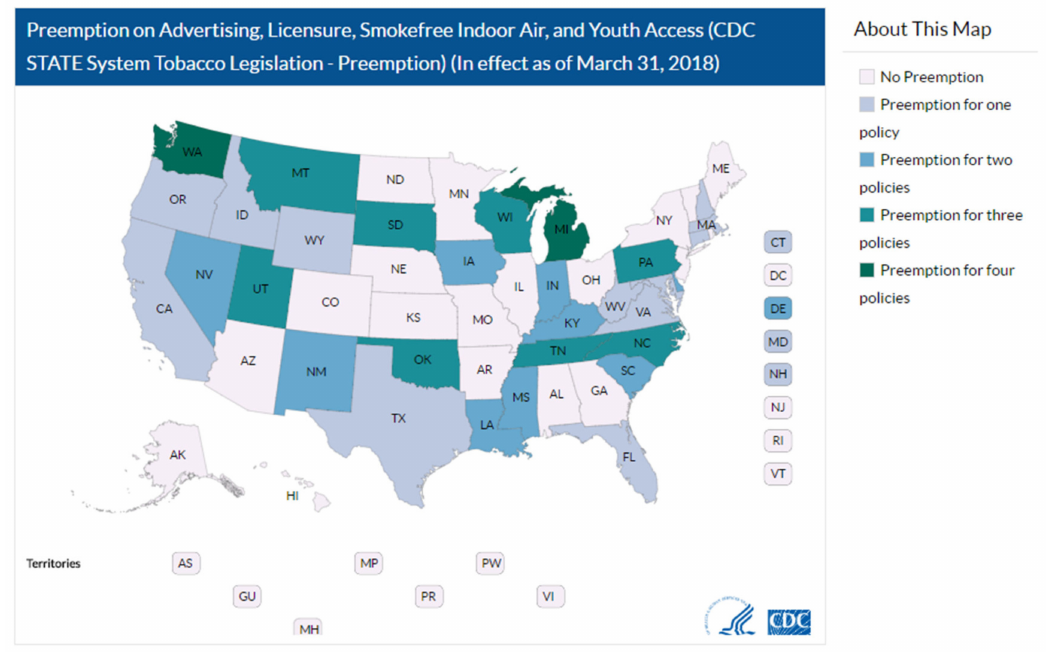
Figure A1. This Geographic Information System (GIS) Map by the U.S. Centers for Disease Control and Prevention (CDC) shows state preemption of four-tobacco control measures: advertising, licensure, smoke-freeindoorair, andyouthaccess. Tennessee(TN),wherethestudywasconducted, preemptsthree of the four tobacco control measures; Advertising, Smoke-free Indoor Air, and Youth